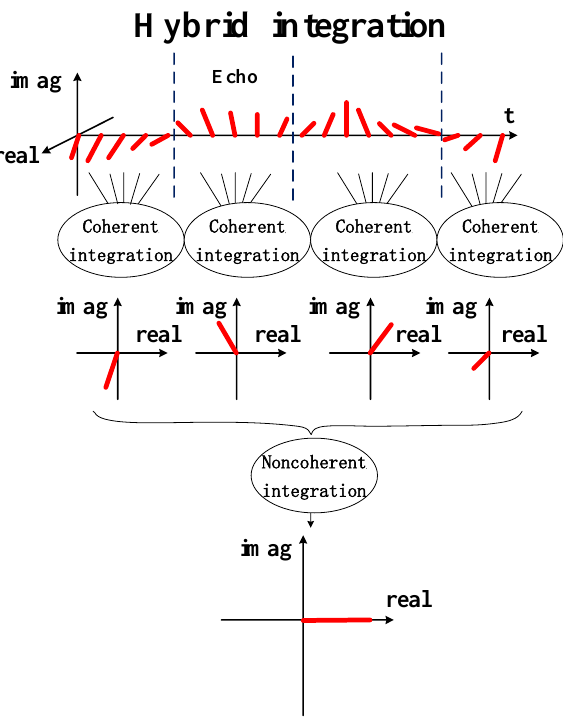
Figure 2. Hybrid integration for partially coherent echo.